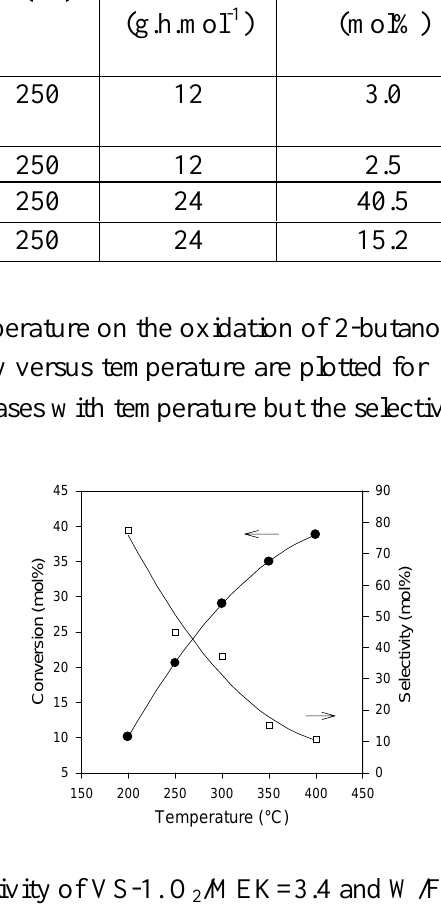
/MEK=3.4 and W/F=24g.h.mol -1 2